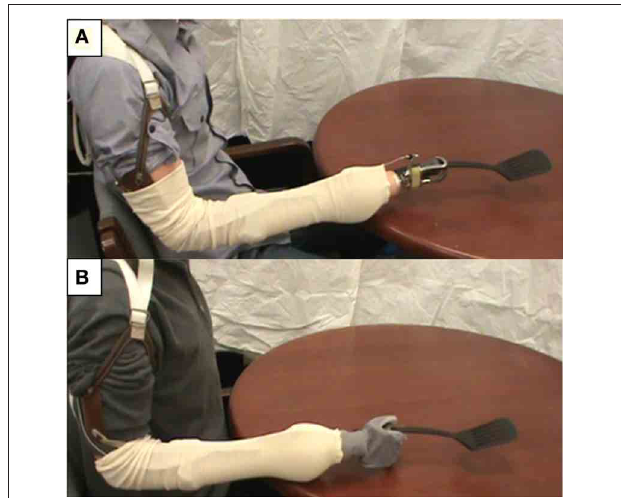
FIGURE 1 | Prosthetic limb terminal devices used in tool use video demonstrations: Hosmer Model 5X Hook (A) and simple articulated anthropomorphic hand